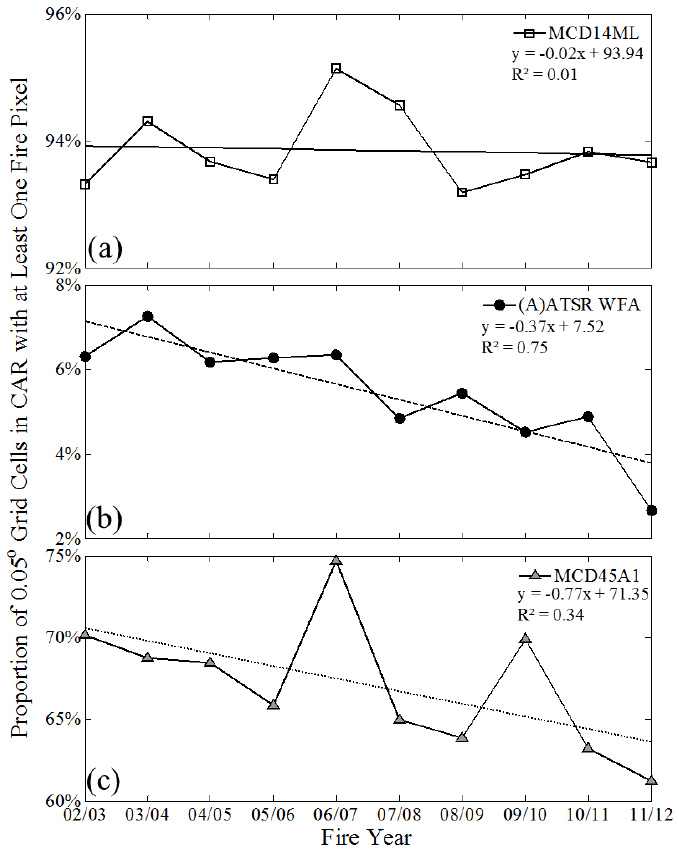
Figure 5. Decadal trends in annual fire occurrence characterized according to the proportion of 0.05° grid cells in the CAR that contained at least one fire pixel recorded in ( a ) the MODIS active fire product; ( b ) the (A)ATSR nighttime world fire atlas; and ( c ) the MODIS burned area product. Trends in annual fire occurrence coincide with a transition in measured active fire characteristics and burned area patterns (Figure 4), and differences in these trends contribute to the reduced agreement between the datasets towards the end of the study period (Figure